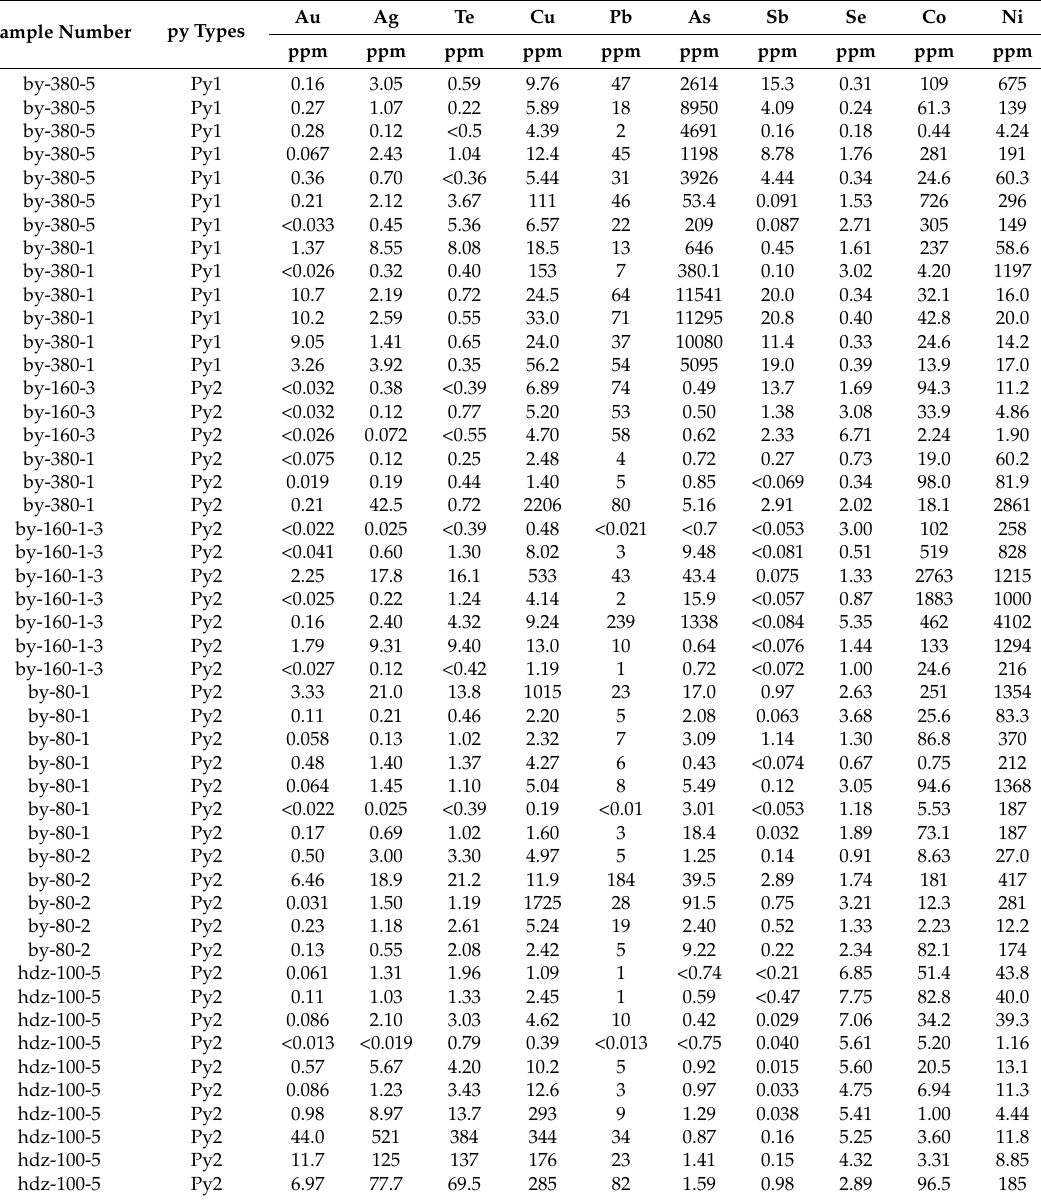
Table 1. Selected LA-ICP-MS analyses of different pyrite types from Baiyun